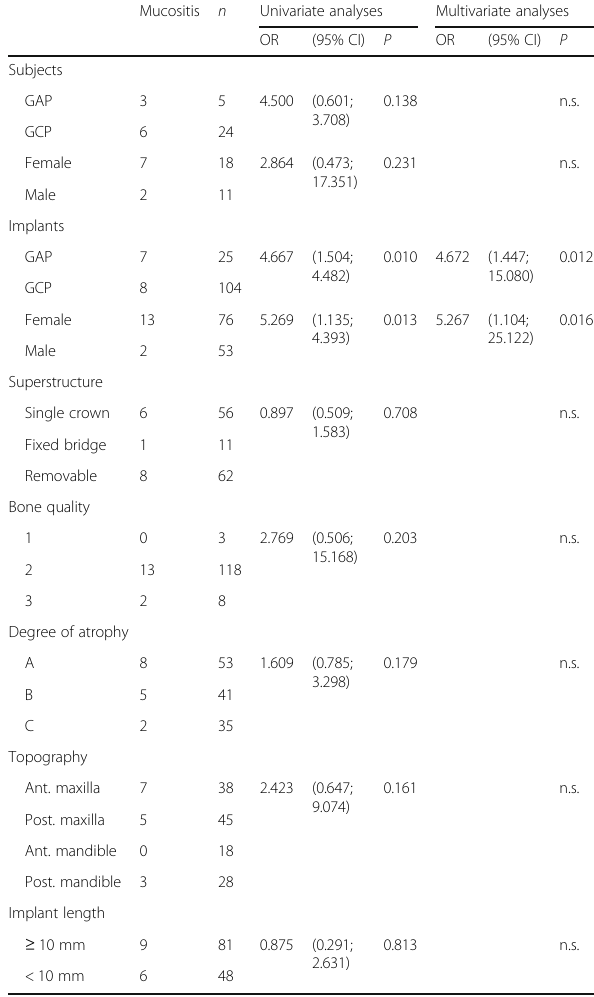
Table 3 Risk factors for mucositis Mucositis n Univariate analyses Multivariate